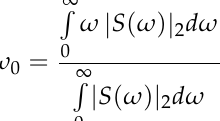
Figure 1. Determination of the parameters of the spectrum ω 0 and ∆ ω of the Doppler signal x ( t ) by the method of moments. W ( V ) is the velocity distribution of the reflecting elements of the object’s surface.